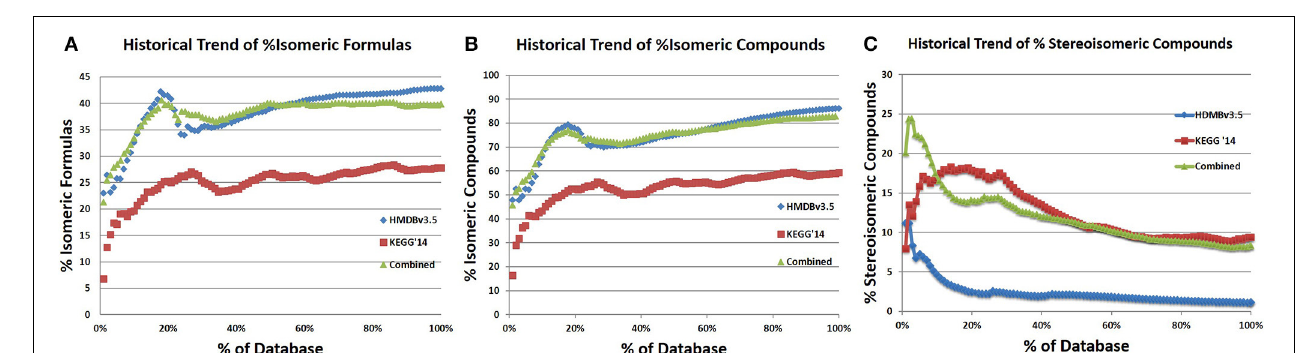
FIGURE 12 | Historic trends of % isomeric molecular formulae and compound entries. (A) The historical trend in % isomeric formulae was determined by analyzing the isomeric content ofa growing percentage of the database, following the sorted order of IDs. This was done by iteratively adding 1% of each database to a temporary database, calculating how many distinct formulae there are in the database and the number of formulae for which there is only one compound, which is the number of isomeric formulae. For both HMDBv3.5 and KEGG’14, the % isomeric formulae